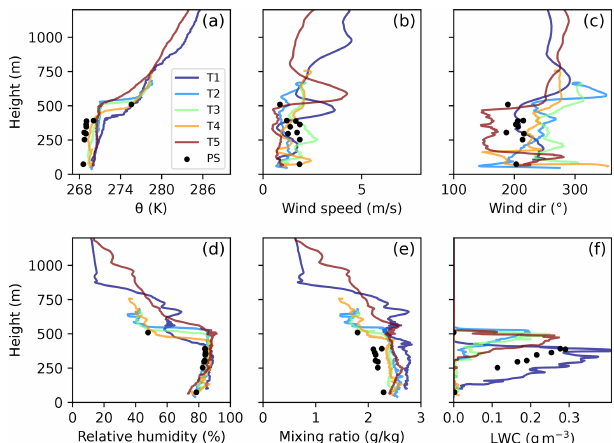
Figure 3. Vertical profiles of the mean potential temperature, wind speed and direction, absolute and specific humidity, and the liquid water content obtained during slant ascents and descents of Polar 6 on its way to PS and back on 5 June 2017. The locations of the ascents and descents are shown in Fig.